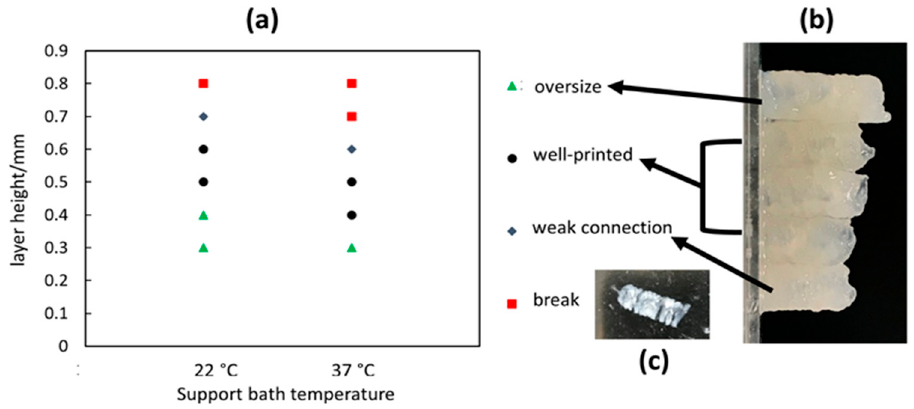
Figure 6. Effect of support bath temperature on the printed tubular structure quality. ( a ) The plot of the printed tubular structures quality as a function of support bath temperature and layer height; ( b ) Color image of the 3 types (“oversize”, “well-printed”, “weak connection”) tubular structures; ( c ) Color image of “break” tubular structure.